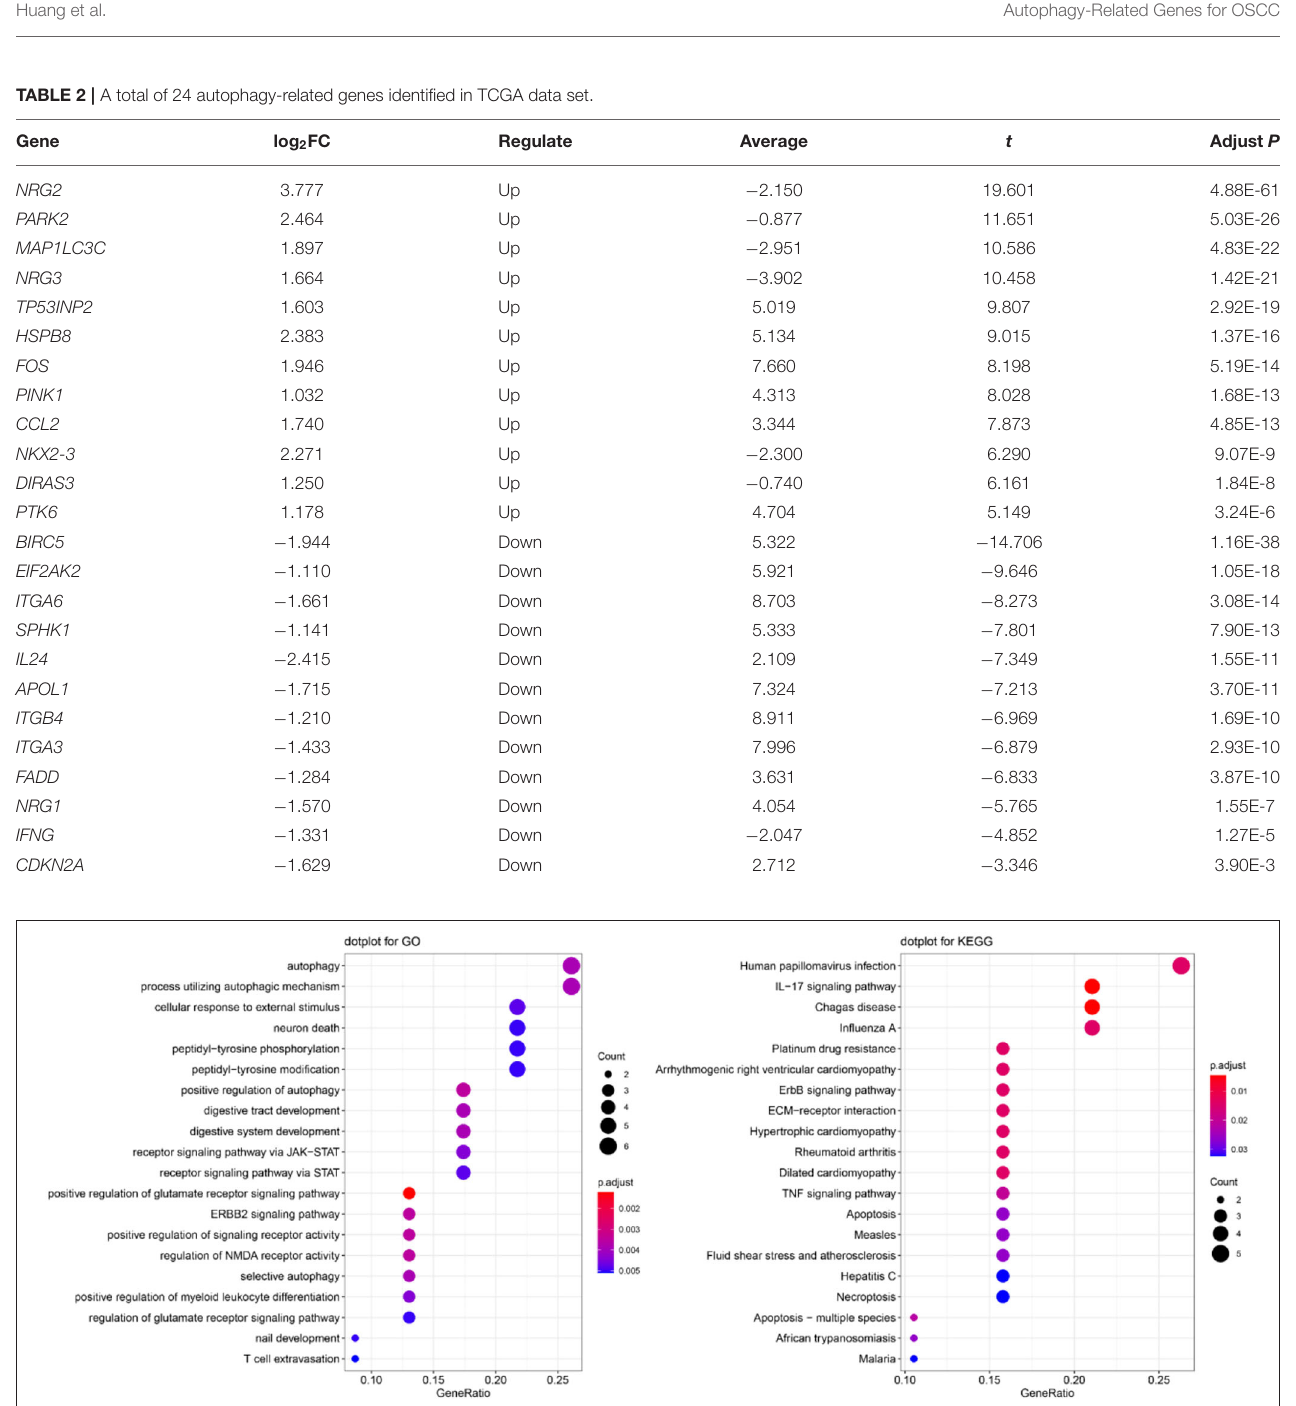
FIGURE 3 | GO and KEGG pathway enrichment analyses for 24 autophagy-related genes.